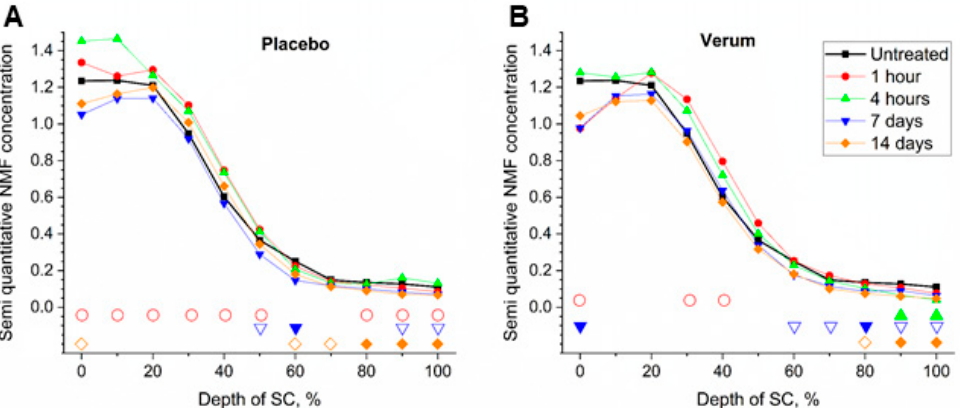
Figure 3. Mean content of natural moisturizing factor (NMF) of all subjects before (untreated, black squares) and 1 h (red circles), 4 h (green upward triangles), 7 days (blue downward triangles) and 14 days (orange diamonds) after beginning of the treatment with the placebo ( a ) and verum ( b ). The signals are normalized to the thickness of the SC (0–100%). Significant differences ( p < 0.05) are marked below in empty shapes, strongly significant differences ( p < 0.01) in solid shapes.